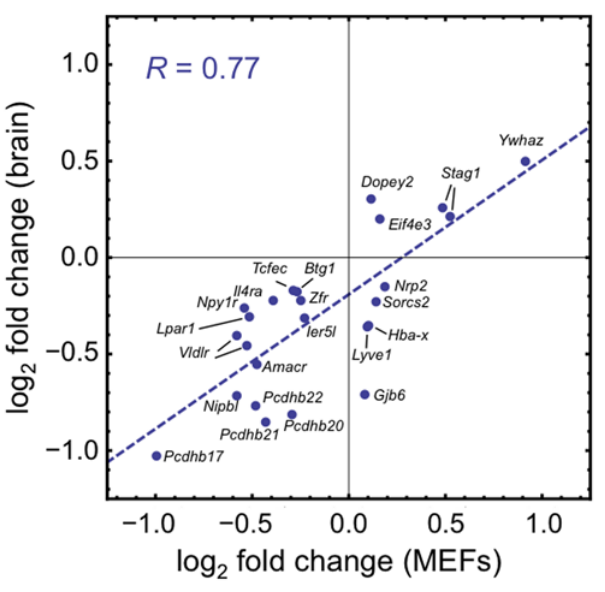
Figure 7. Gene expression effects are correlated across cell/ tissue types. Comparison of gene expression profiles of E13.5 brain and MEFs (cf. Table S2 and Table S3, respectively) identified 25 probe sets for which differential expression between wildtype and Nipbl + / 2 samples displayed a t-statistic with an absolute value . 2 in both brain and MEFs. For each such probe set, the log2-transformed expression change in MEFs was plotted against the log2-transformed expression change in brain. Points are labeled by gene symbol. The observed correlation (correlation coefficient=0.77) indicates that, for those transcripts affected in both mutant brain and mutant MEFs, the directions and magnitudes of the expression changes are often similar. This suggests that such transcripts may be ‘‘direct’’ targets of NIPBL. Note the presence of Stag1 , which encodes a cohesin subunit.